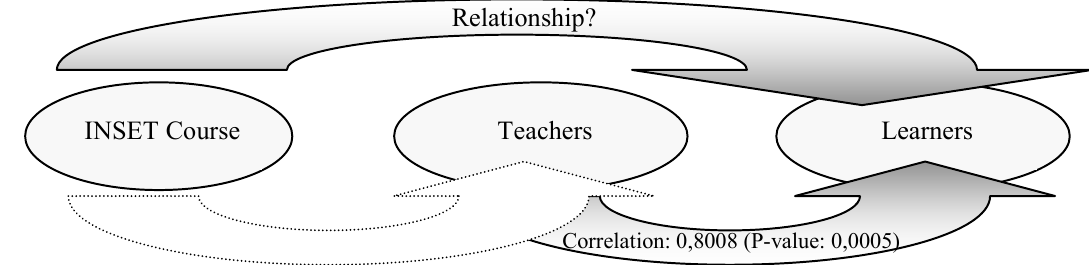
Figure 2. The relationship between teachers’ and learners’